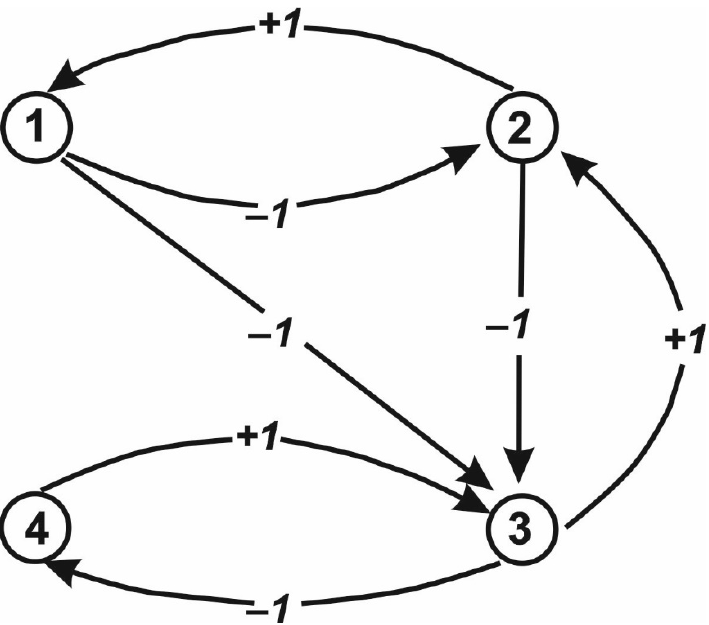
Figure 4. Digraph of the SVC of BL. 1—initial pastures, 2—community of wormwoods; 3—community of annual weed species, 4—open sands.